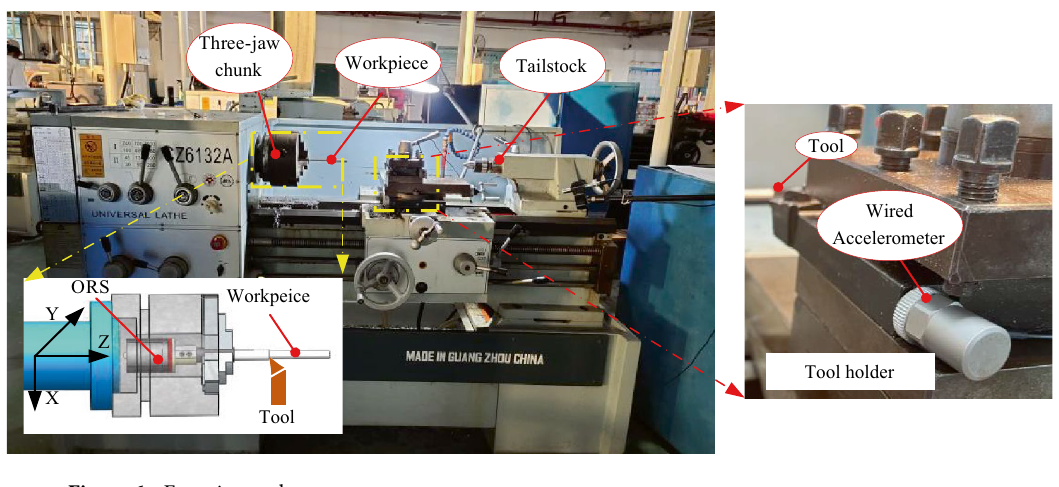
Figure 6. Experimental